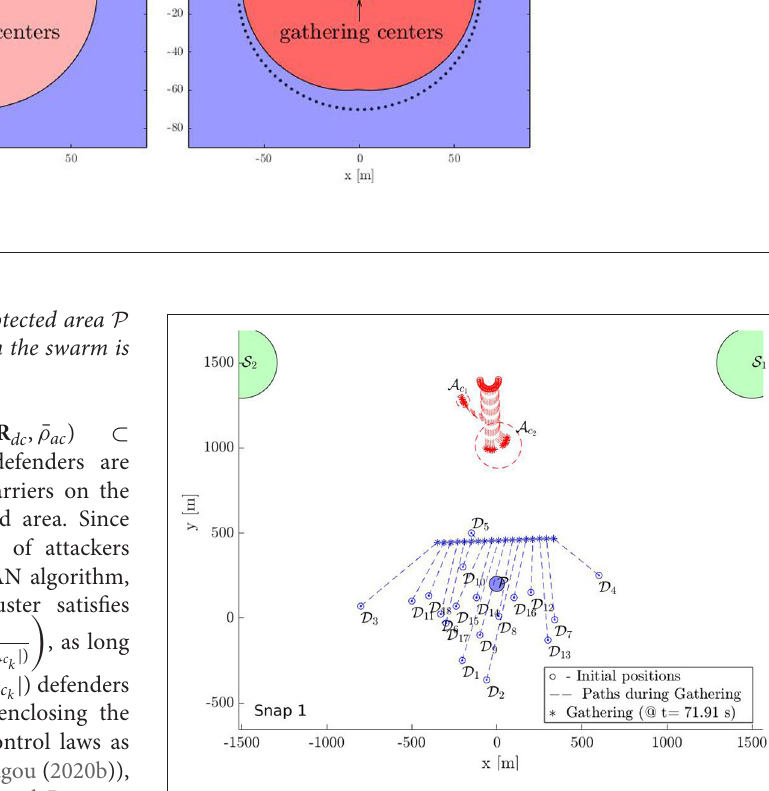
FIGURE 9 | Multi-Swarm StringNet Herding: Snapshot